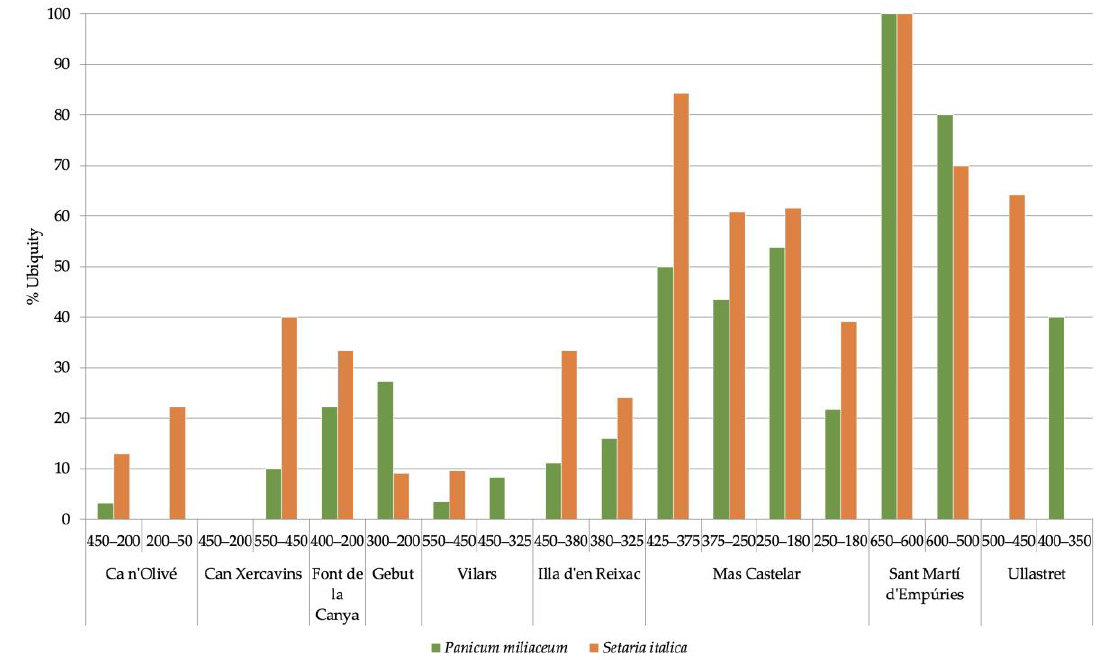
Figure 5. Comparison of the percentage of ubiquity of broomcorn millet and foxtail millet in settle- ments of the northeast of the Iberian Peninsula during the Iron Age.